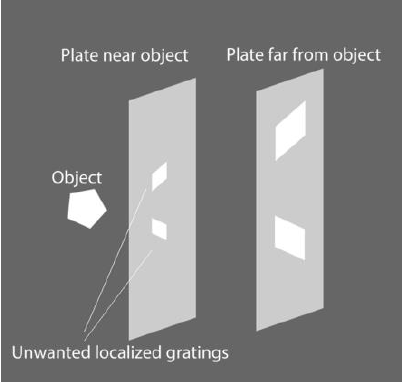
Figure 13. Specular reflections produce unwanted diffraction gratings obscuring the diffuse Specular reflections produce unwanted di ff raction gratings obscuring the di ff use holographic image. holographic